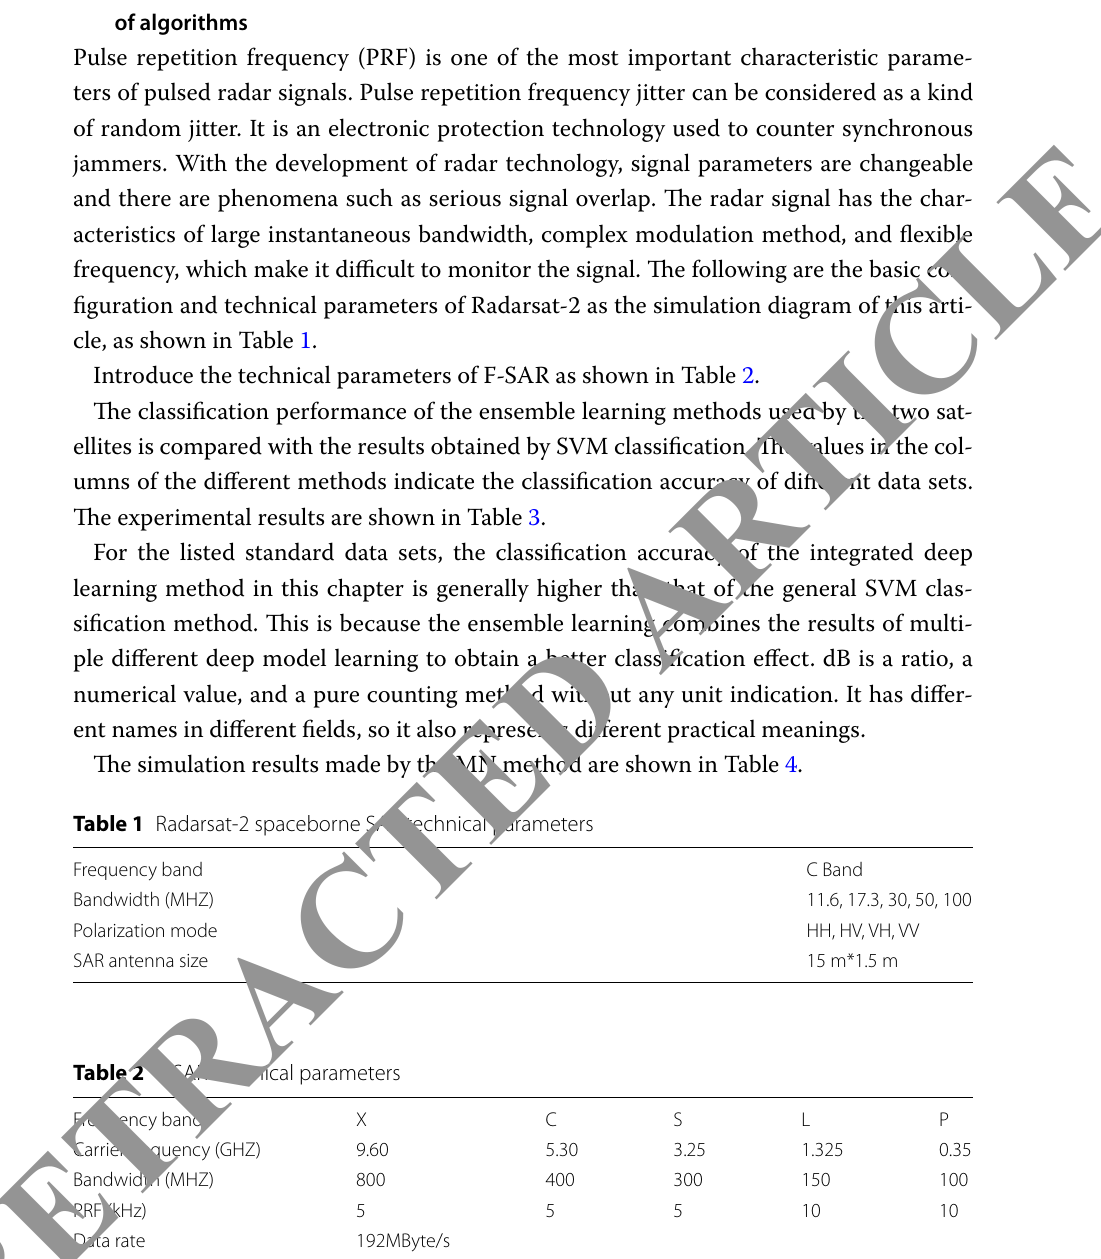
Table 2 F-SAR technical parameters Frequency band Carrier frequency (GHZ)